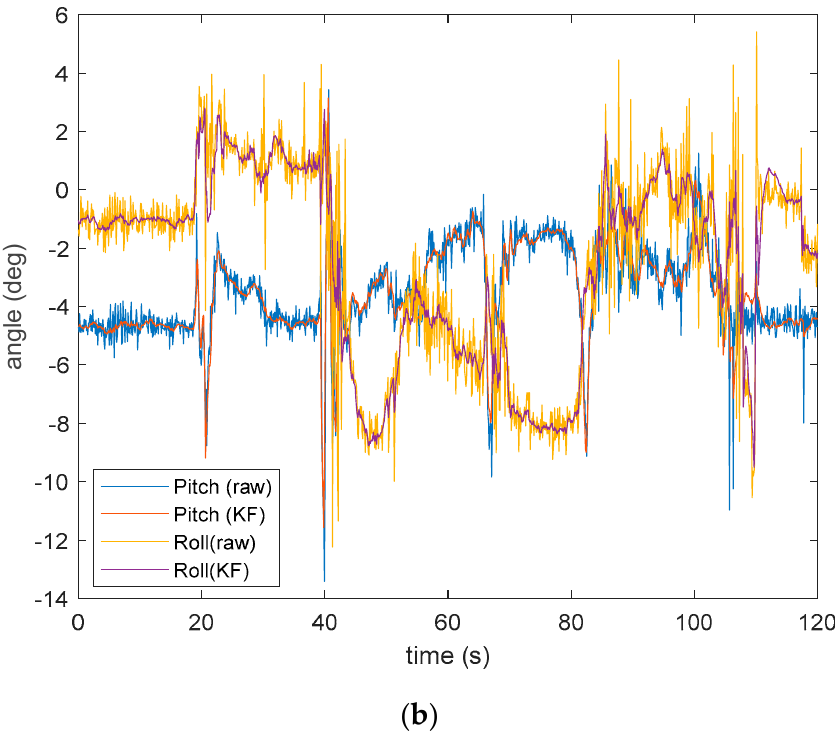
Figure 10. ( a ) Landing with intermediate hovering stations: raw and filtered LiDAR distances from the ground. ( b ) Raw and filtered calibrated attitude data (pitch and roll).